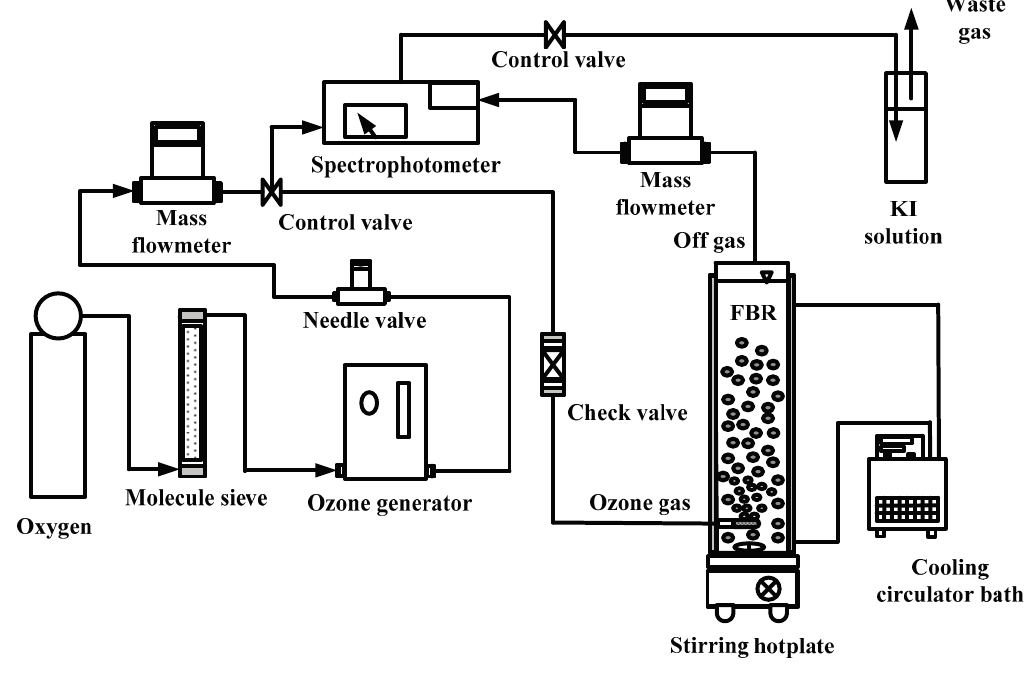
Figure 1. Schematic representation of the catalytic ozonation system.